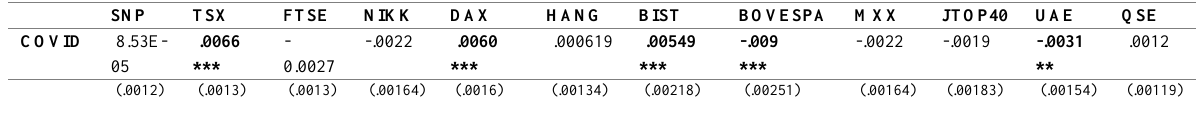
Table 8: Coefficient of Covid-19 in Short-Run